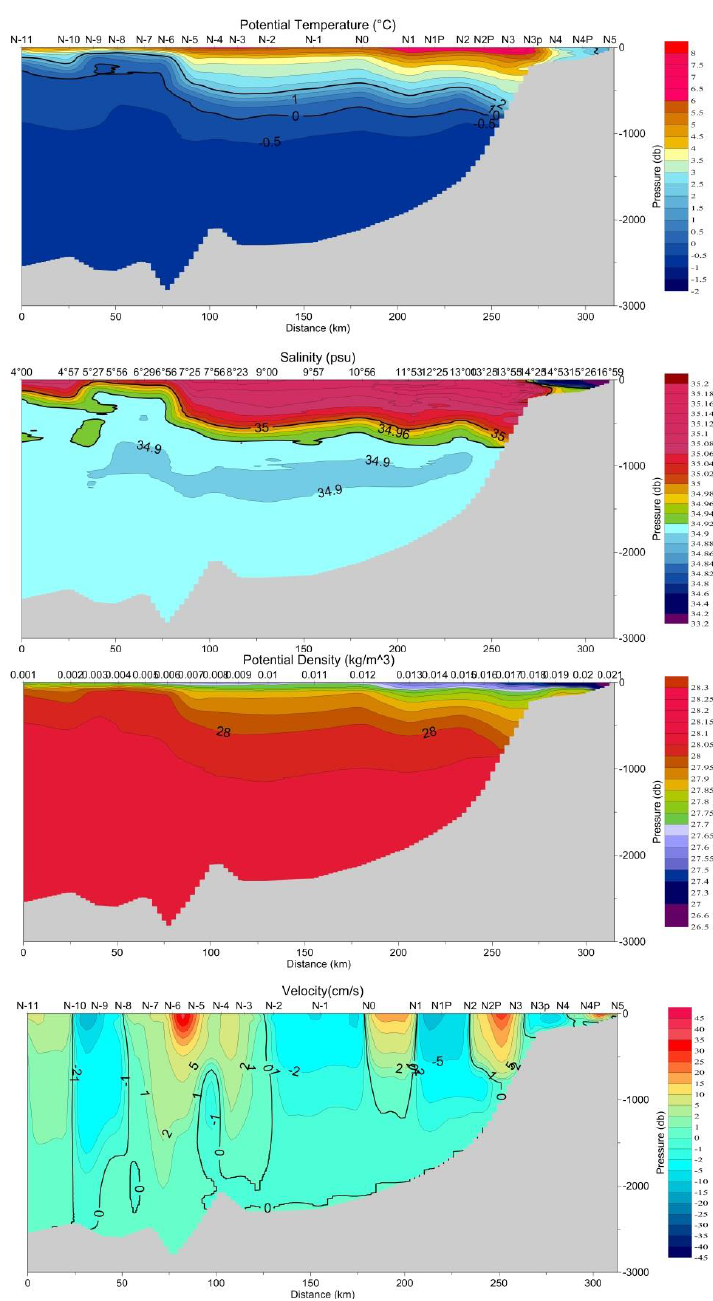
Fig. 4. Section “N” cross the Atlantic domain, along the latitude 76 ◦ 30 0 N, between meridians 004 ◦ E and 017 ◦ E. (a) Potential temperature, Figure 4. Section ‘N’ cross the Atlantic domain, along the latitude 76°30’ N, between 3 (b) salinity, (c) potential density and (d) baroclinic currents fields in summer 2009. The 200m thick layer of the return AW west of the AF is meridians 004° E and 017° E. (a) Potential temperature, (b) salinity, (c) potential density and 4 (d) baroclinic currents fields in summer 2009. 200 m thick layer of the return AW west of the 5 AF is visible. 6